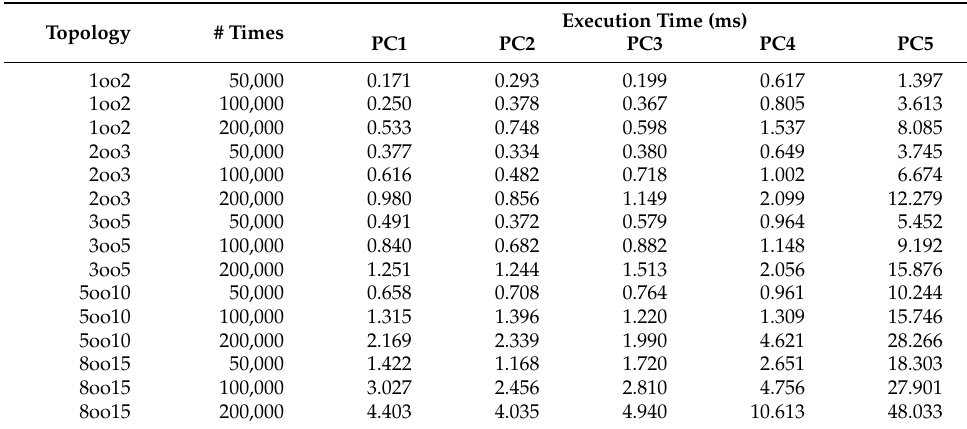
Table 10. Performance evaluation of N /2oo N identical block.